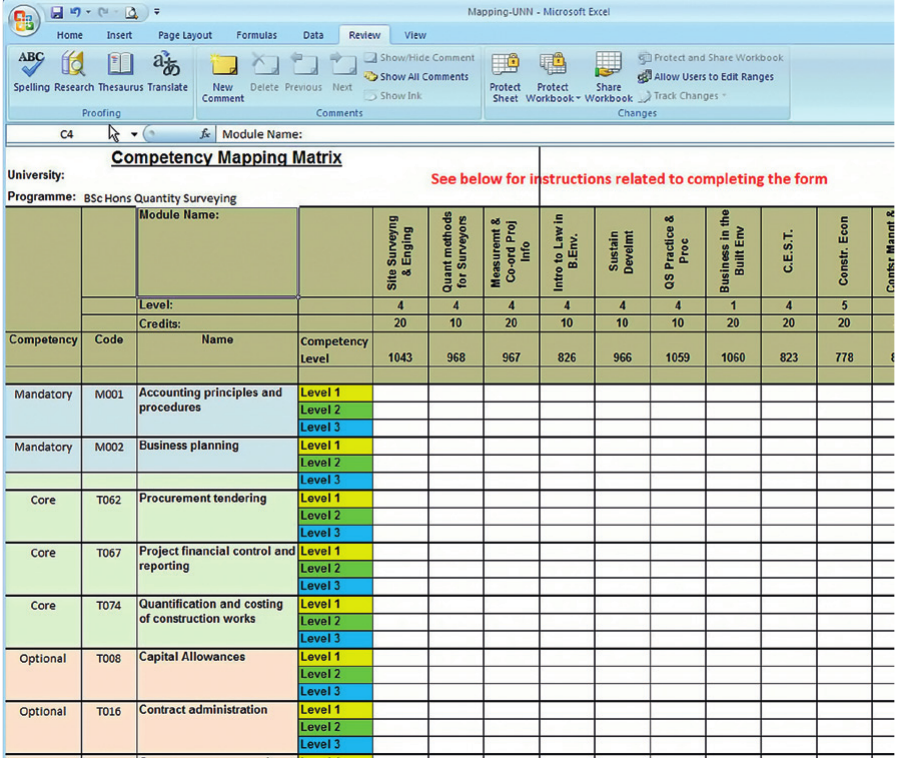
Figure 2. Competency mapping matrix